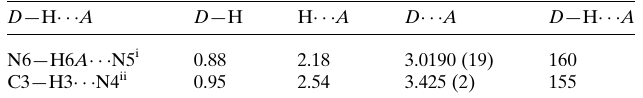
Table 1 Hydrogen-bond geometry (A˚ , (cid:2) ).